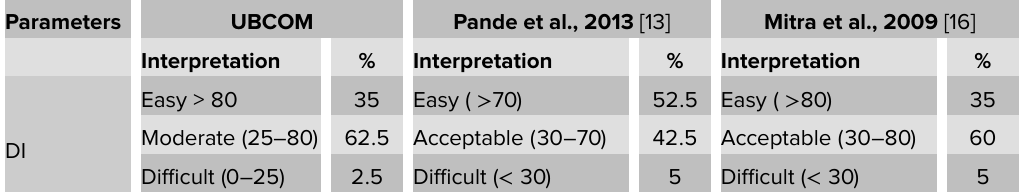
TABLE 1: Classification of examination items according to difficulty index.